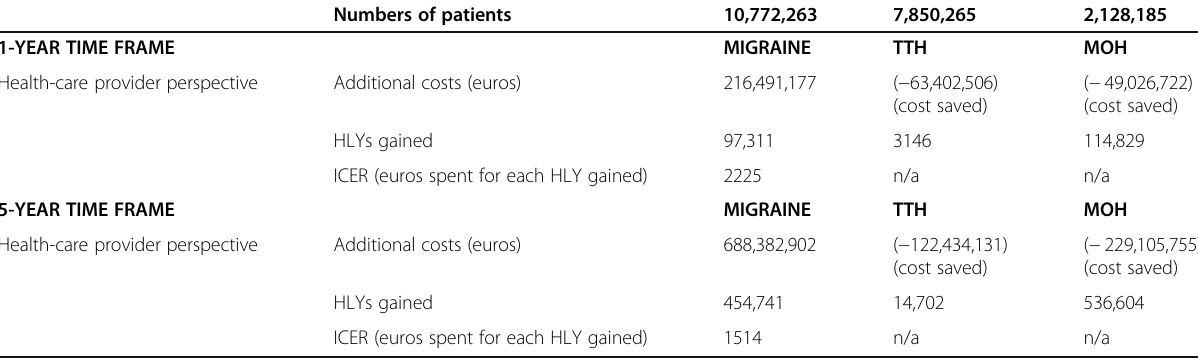
Table 3 Spain: economic consequences of changing from current to target care (population